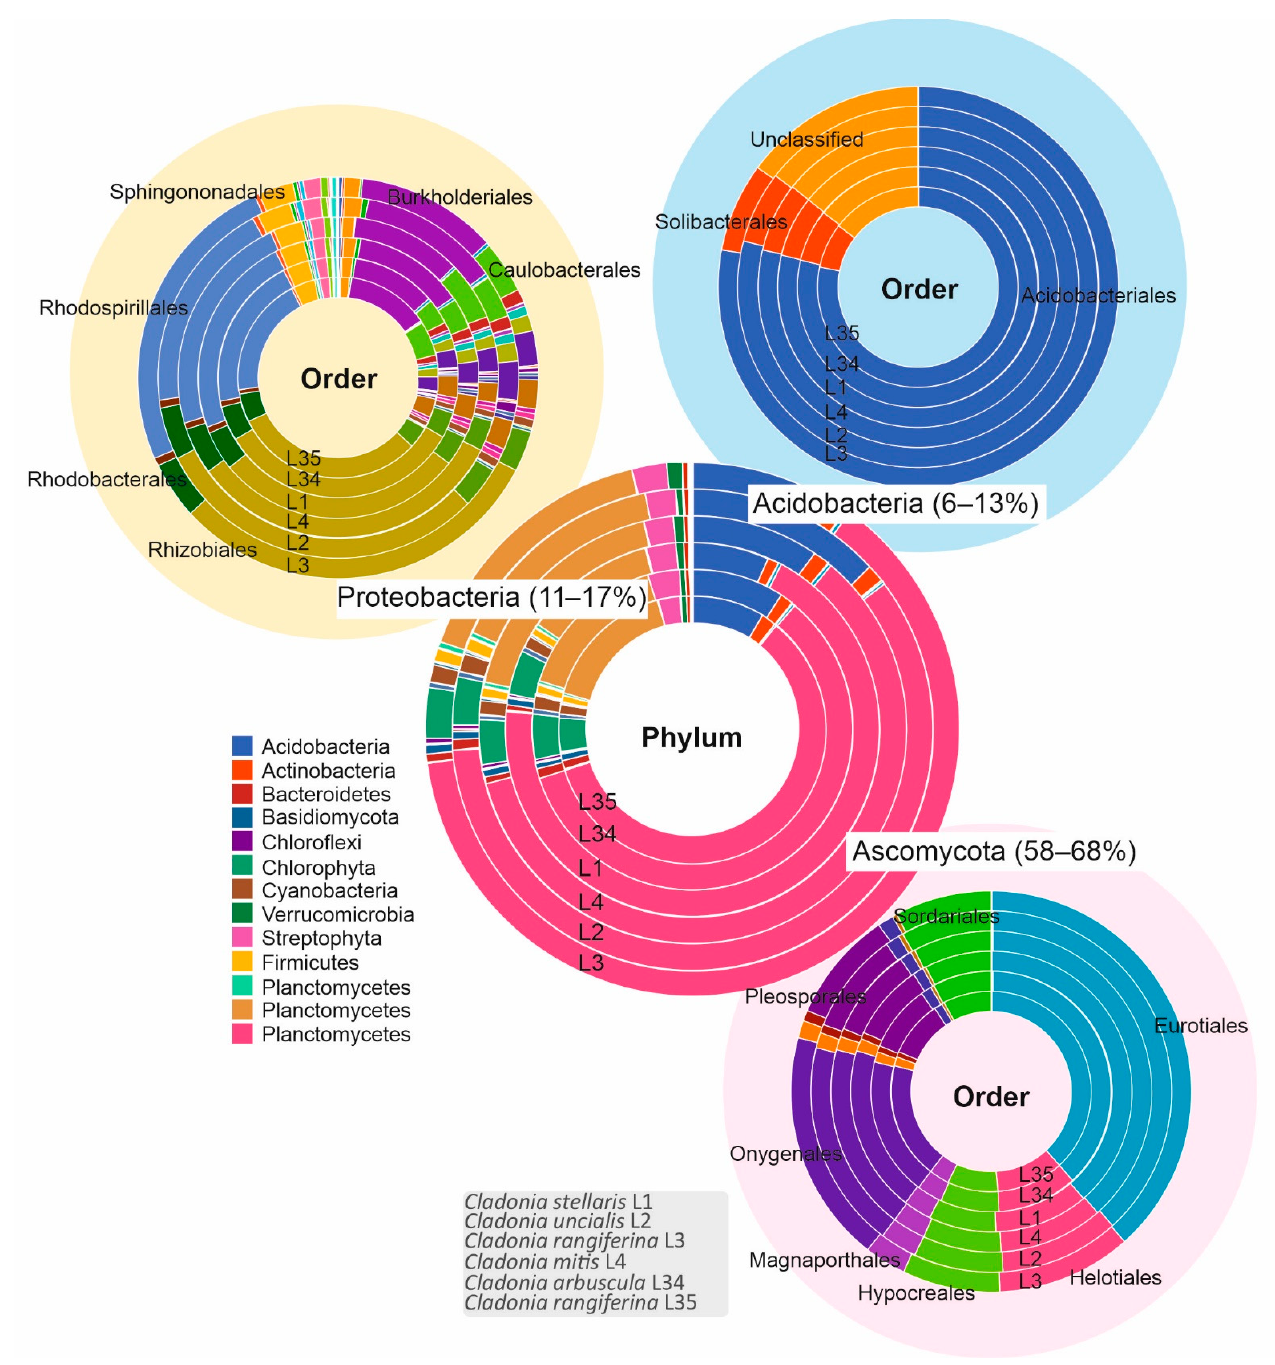
Figure 2. Taxonomic annotations of the metagenomics reads obtained using RefSeq best hit from the metagenomics analysis server (MG-RAST). The circle in the middle is larger and shows the most common phyla present in each sample (L1–L4, L34, L35) and their percentage range for three dominant phyla (Ascomycota, Proteobacteria, and Acidobacteria). Other phyla present in the samples are indicated in the colour legend beside the middle circle. The three smaller circles show the most common orders detected from Ascomycota (light pink), Proteobacteria (light yellow), and Acidobacteria (light